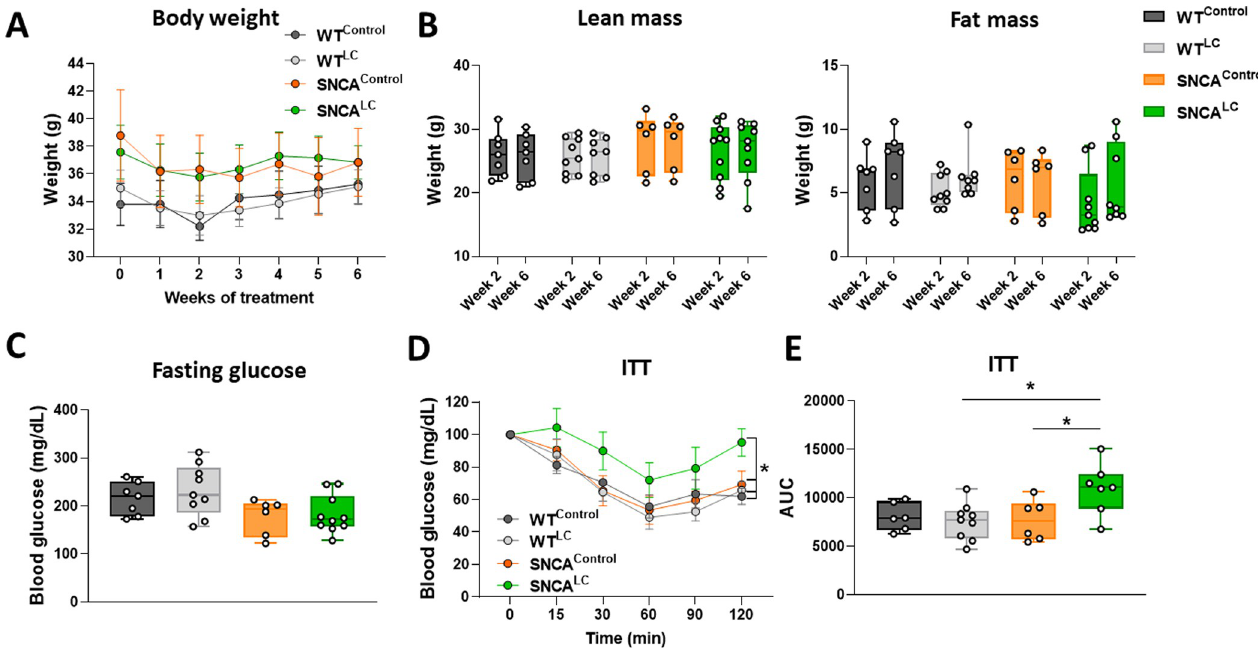
Fig 5. LC-NE chronic stimulation promotes systemic insulin resistance in α -syn overexpressing animals. A- Changes in body weight over 6 weeks during CNO treatment, (n = 6–9). B- Lean and fat mass at weeks 2 and 6 of chronic LC-NE stimulation (n = 6–9). C-Fasting blood glucose levels on week 6 of LC-NE chronic stimulation (n = 6–9). D- Insulin tolerance test performed at week 6 of CNO treatment, (n = 6–9). E- Insulin tolerance testing area under the curve analysis 6 weeks after beginning of the CNO treatment (n = 6–9). � p < 0.05, all values denote means ± SEM.